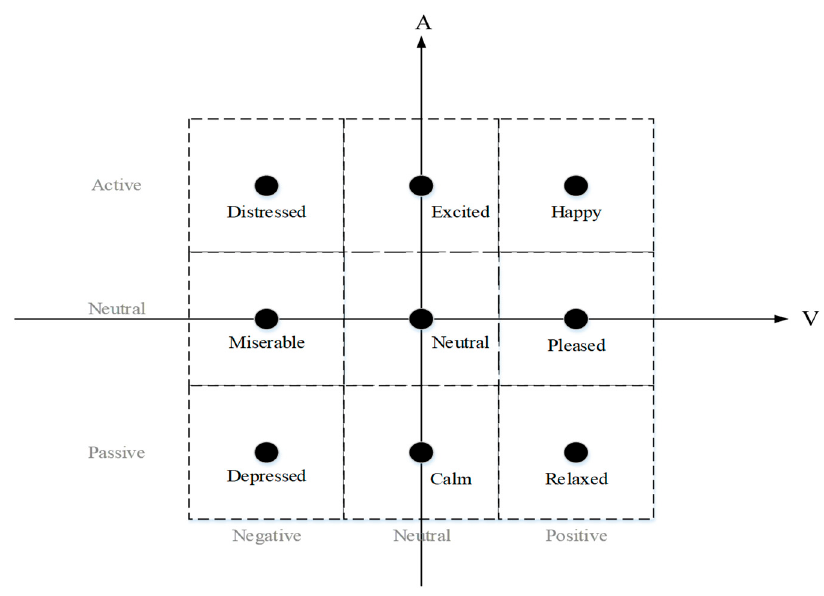
Figure 3. Nine emotions in the SAM scale.